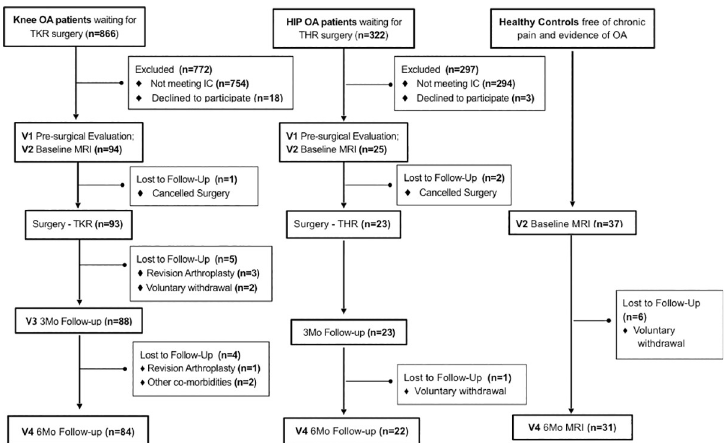
Fig 2. Recruitment and retention for KOA and HOA, and healthy control participants. The full battery of assessments was performed in osteoarthritis patients. Healthy individuals were recruited to act as controls in brain imaging analyses (not reported here). All patients were recruited from the same tertiary care hospital. Healthy participants were recruited from the general population in the Porto area. IC, Inclusion criteria; MRI, magnetic resonance imaging; KOA, knee osteoarthritis; HOA, hip osteoarthritis; THR, total hip replacement; TKR, total knee replacement.